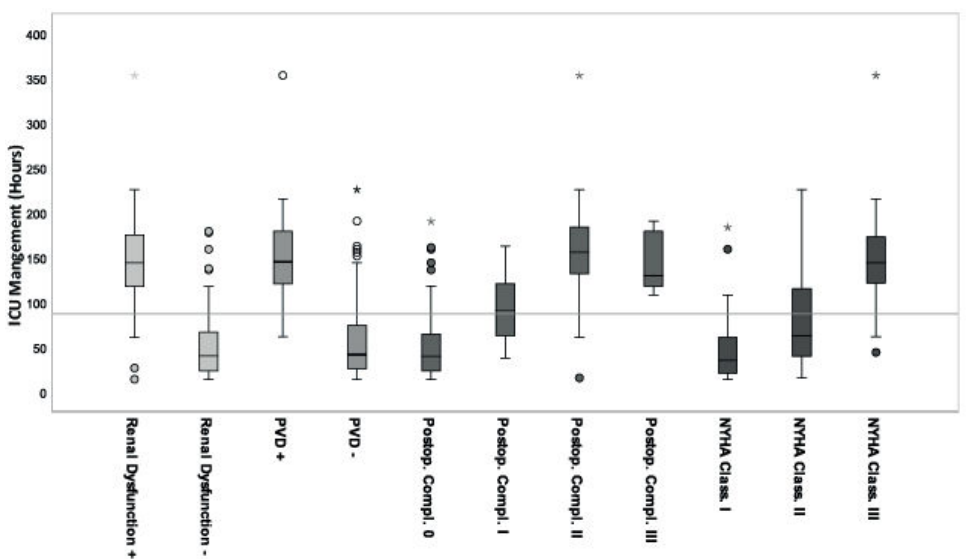
Figure 4. Pre-operative significant parameters in correlation to ICU-LOS ( n = 122) according to the calculated univariate general linear regression model. The grey line marks the mean ICU-LOS, 87 ( ± 63.3) h, 3.6 days. Each significant parameter is given as standard boxplot diagram including the marked median, the interquartile range (IQR), the 1.5xIQR and the extreme values. Extreme values are marked as circles (1.5-3xIQR) and stars (>3xIQR). (ICU: Intensice Care Unit, PVD: Peripheral Vascular Disease, NYHA Class.: Extent of Heart Failure according to the New York Heart Association Grade Classification, Postop. Compl.: Postoperative Complication according to the Clavien-Dindo Classification Grades, + positive, -